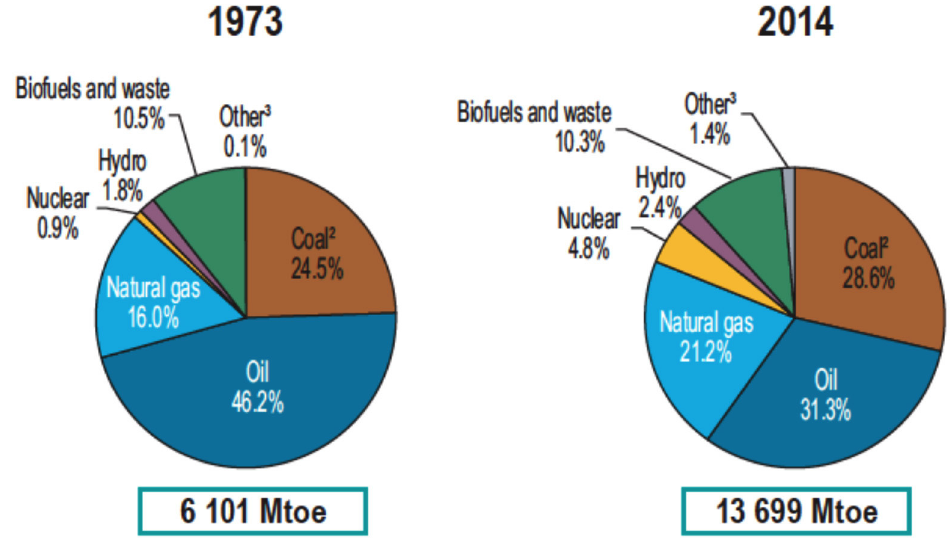
Fig. 3. – 1973 and 2014 fuel shares of TPES. (Courtesy of